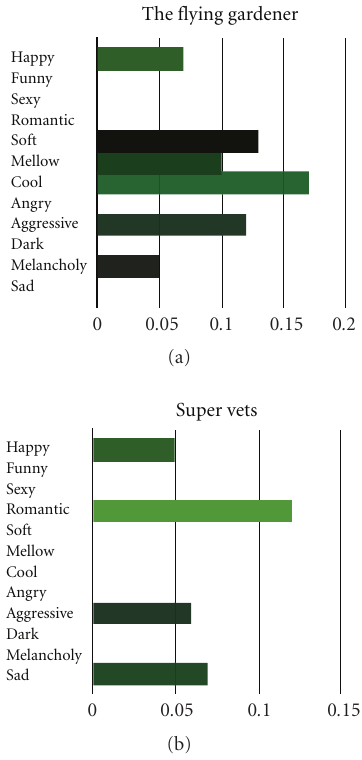
Figure 10: LSA cosine similarity between the synopsis descriptions of “The flying gardener” and “Super Vets” against 12 frequently used last.fm a ff ective